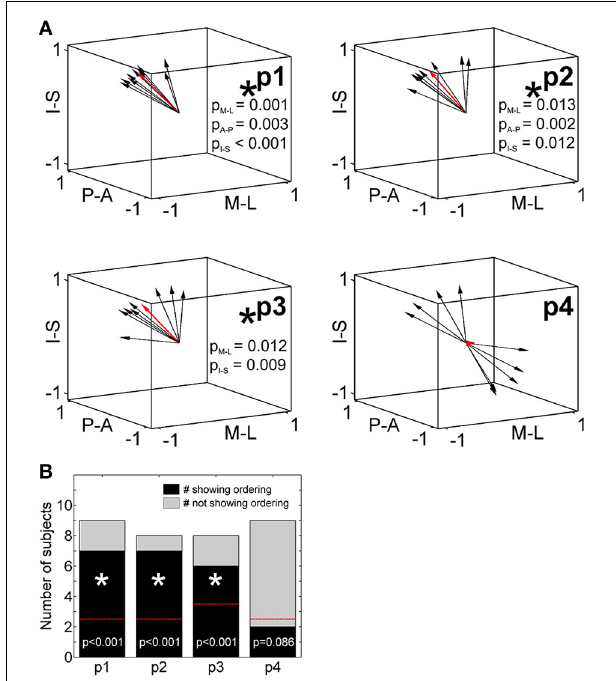
FIGURE 6 | Across-digit direction consistency and ordering. (A) Across-digit direction vectors for p1 to p4 (black arrows, individual direction vectors; red arrows, mean values averaged across subjects; A-P, anterior-posterior; M-L, medial-lateral; I-S, inferior-superior). Across-digit direction consistency is indicated by an asterisk and respective p -values. (B) Across-digit ordering as given by the number of subjects showing (black) or not showing (gray) ordered activations from D1 to D5 along the individual N vectors. The red lines illustrate the minimal number of ordered subjects needed to observe across-digit ordering. Phalanges showing ordering are indicated by an asterisk and respective p